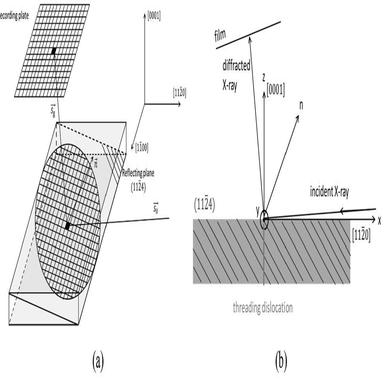
(a) Schematic diagram for ray-tracing simulation; (b) Coordinate system setup used for ray tracing simulation in grazing incidence geometry.